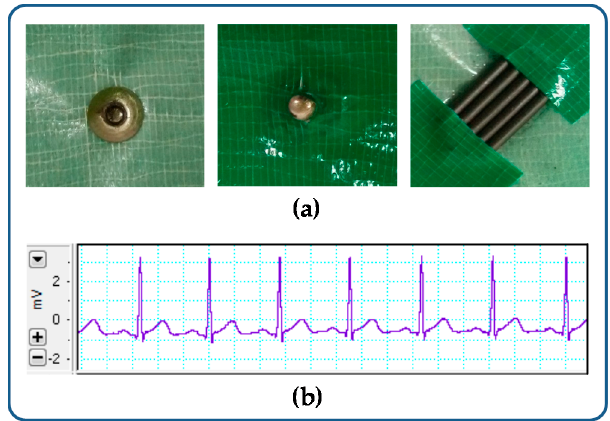
Figure 1. Pre-experiment for testing the usability of a graphite pencil lead electrode. ( a ) GPL on the metal cap; ( b ) Resultant signal.